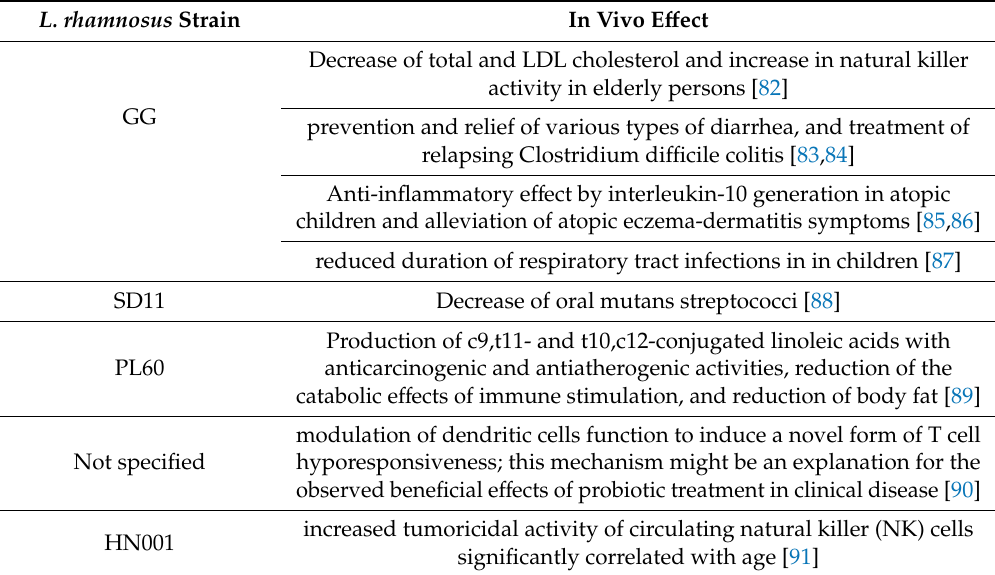
Table 2. Beneficial e ff ects exerted in vivo by L. rhamnosus strains in human